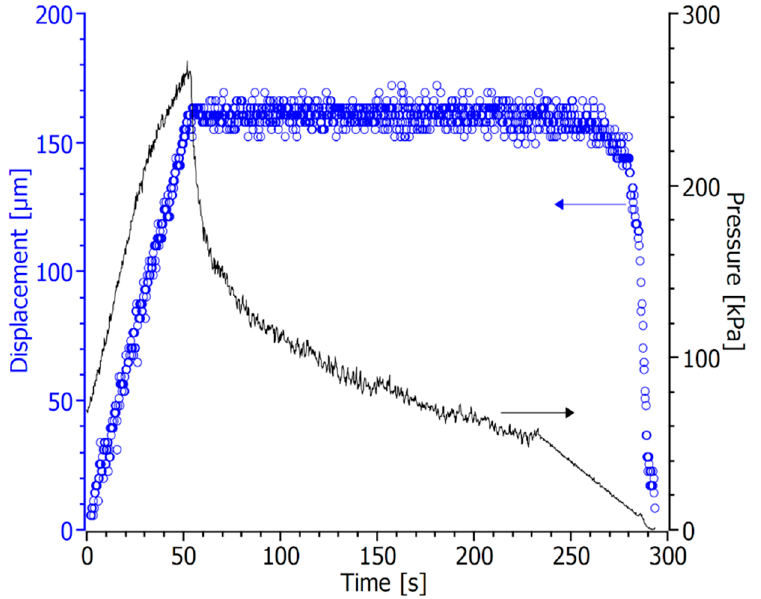
Figure 4. Evolution of sample deformation ( ○ ) detected by the extensometer and pressure ( − ) measured by the load cell during a lamination experiment, assuming t = 0 as the instant when contact between the plates and the stack is reached.